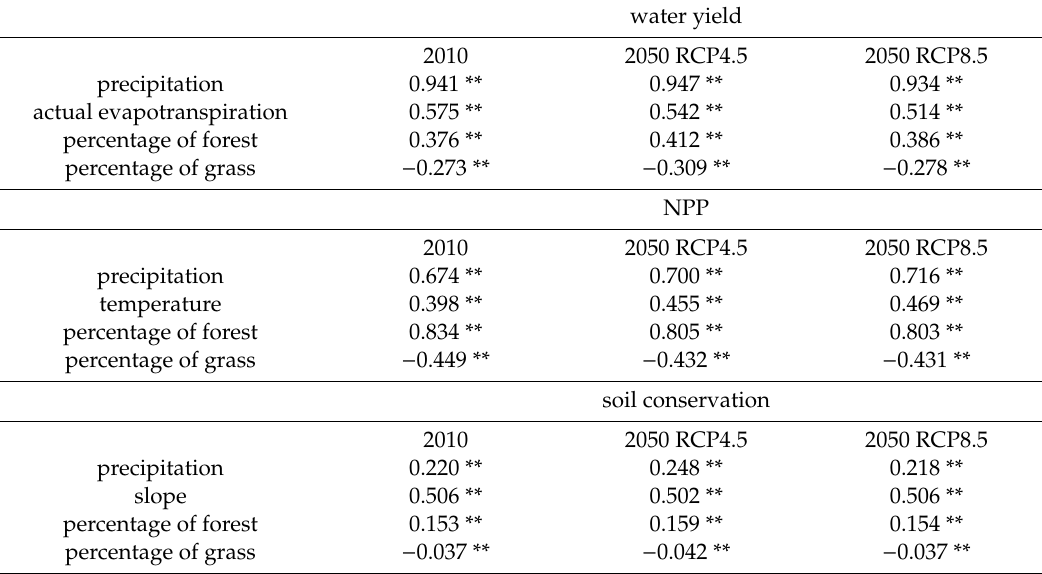
Table 4. Correlation between ecosystem services and impact factors for spatial